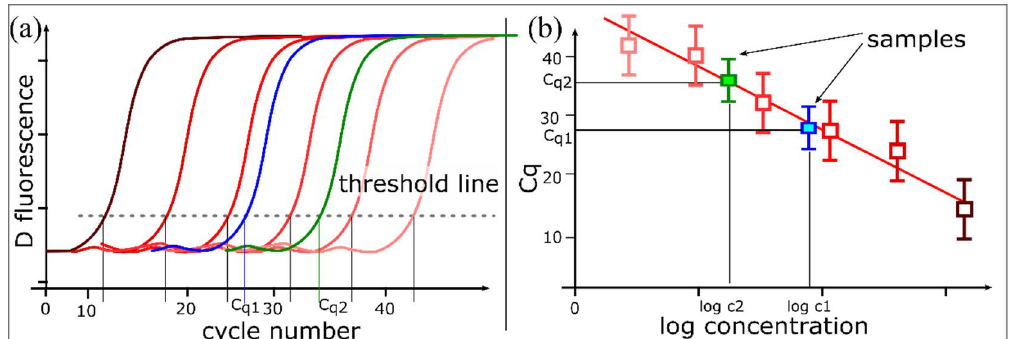
Figure 2. Real-time qPCR assay using a standard curve. ( a ) Amplification curves for a 6-point 10-fold dilution series of a template with known concentrations (standard) over five orders of magnitude (e.g., genomic DNA, PCR amplicon, linearized plasmid). The Cq value of each serially diluted standard is determined; ( b ) A standard curve is generated by plotting the Cq values derived from the amplification curves of the dilution series against the logarithm of the standard quantity. The standard curve is used to interpolate the quantity of the target. The slope of the standard curve measures the amplification efficiency of the qPCR assay. A slope of –3.32 (for a standard curve generated from a serial 10-fold dilution series) indicates 100% amplification efficiency, i.e., the amount of PCR product doubles during each cycle.